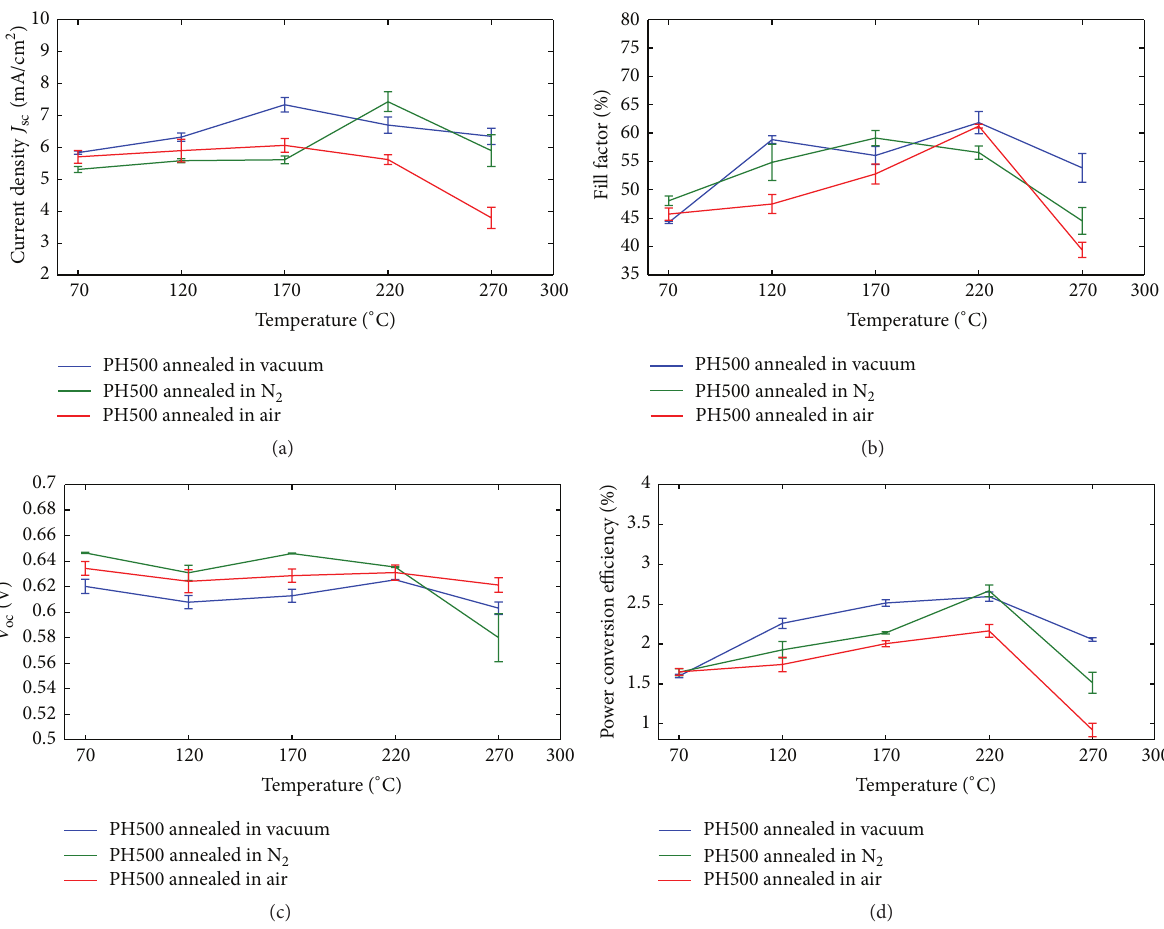
Figure 1: The average variation of photovoltaic parameters of PH500 based devices with temperatures in three different atmospheres.